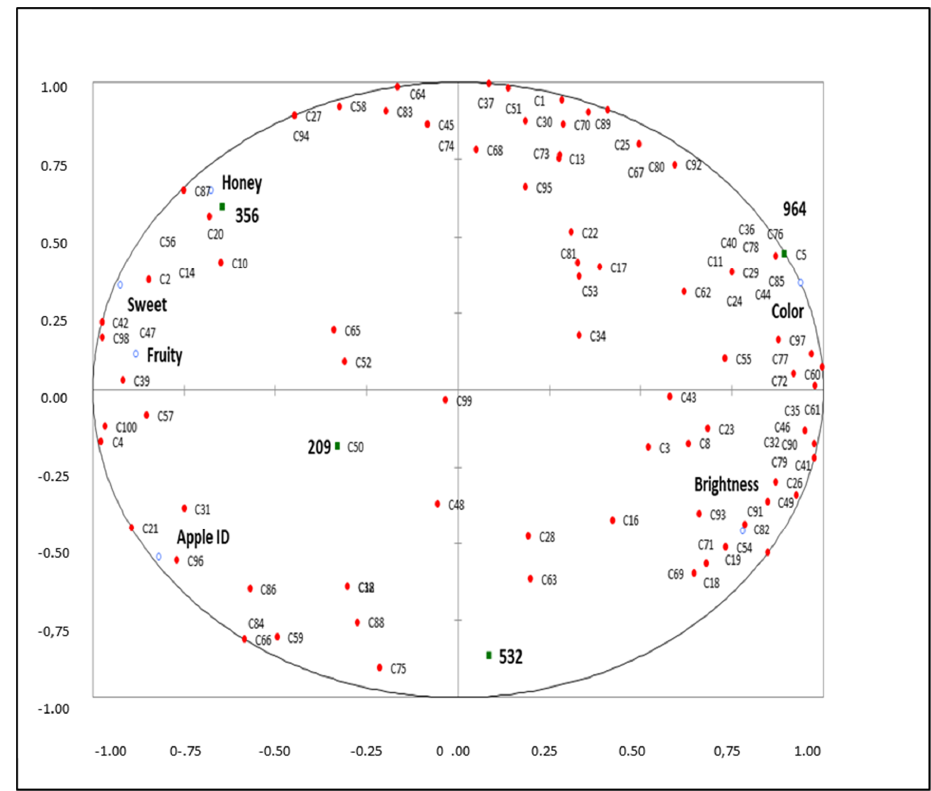
Figure 1. Partial least squares regression (PLS) of the descriptive sensory profile (X) and consumer overallliking(Y)ofthesamples(squares = samples; filledcircle = consumers; unfilledcircle = descriptive